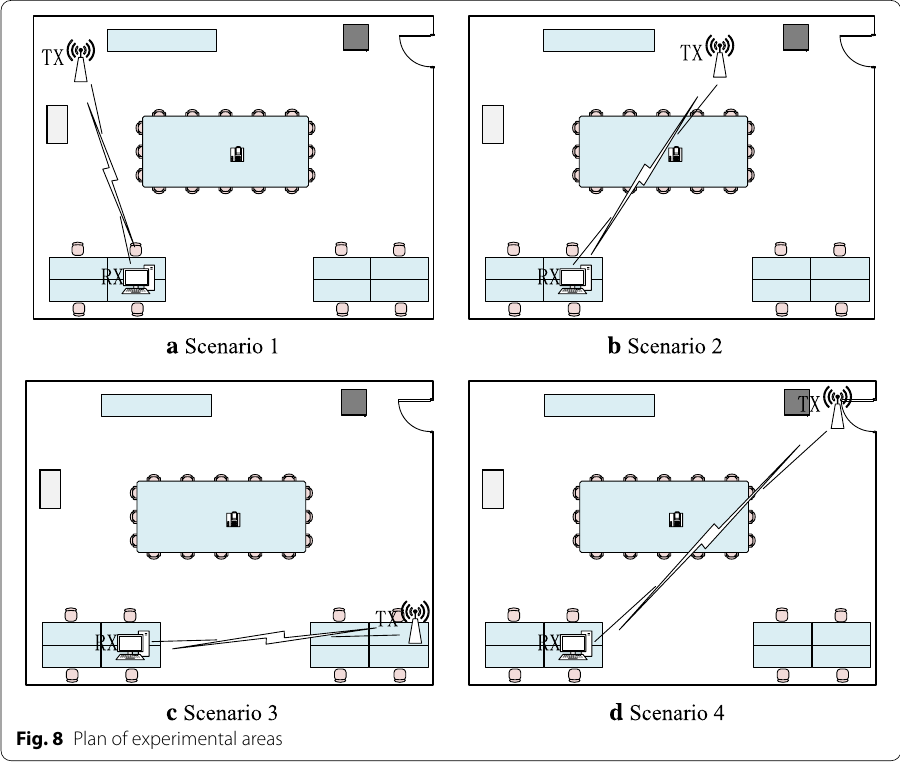
Fig. 8 Plan of experimental areas